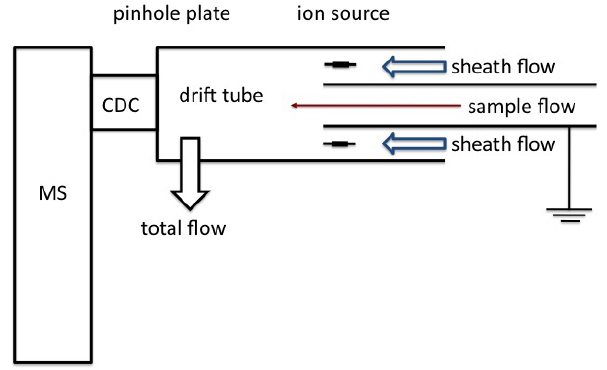
Fig. 2. A schema of the CIMS inlet. CDC and MS refer to collision- dissociation chamber and mass spectrometer,